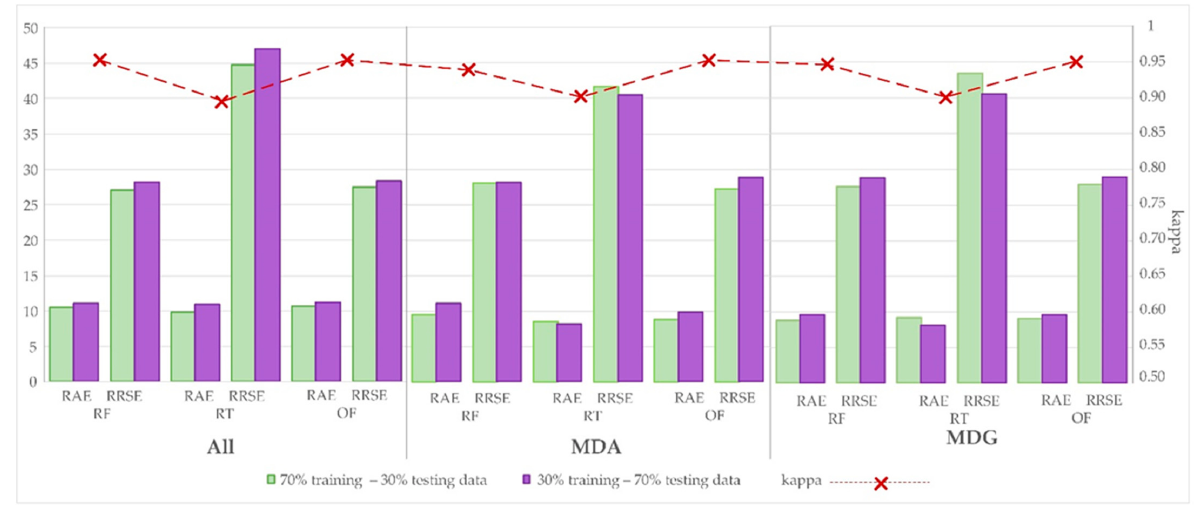
Figure 9. Classification results; ( A ) building classification over hillshade; ( B ) hillshade data; ( C ) detail of building classification over hillshade; and ( D ) high-resolution orthophoto of the same area. The accuracy analysis concerning the classification errors shows similar results where the RF and OF results are similar and outperformed RT. As expected, 70% of the training data was more beneficial with slightly lower errors. However, this was not the case for the RF, where with the MDA and MDG variable selection, RT showed lower errors with the more minor training data set. Nevertheless, the errors of RT in all scenarios were significantly higher than the other two ML methods. As for the kappa statistics, the highest values were noticed using the RF, then OF and RT, respectively (Figure 10).